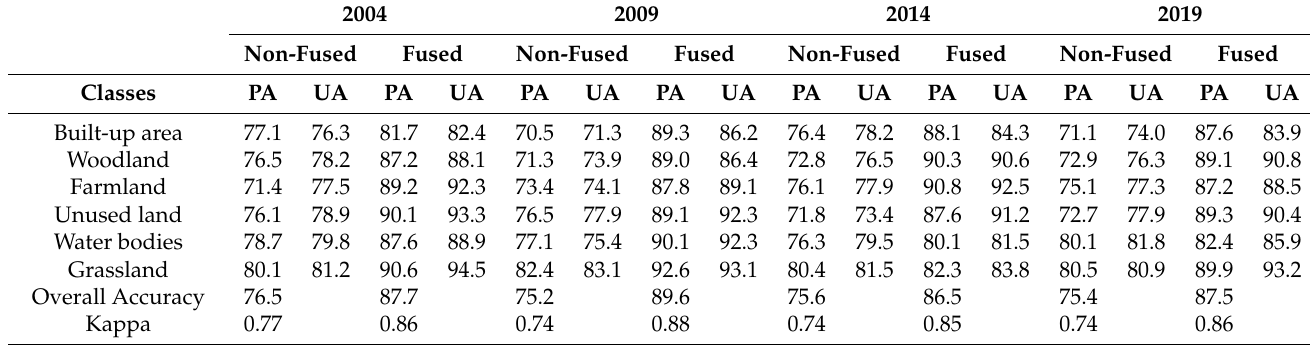
Table 4. Accuracy assessment values for the LULC using non-fused and fused images by 2004, 2009, 2014 and 2019. Producer accuracy = PA; user accuracy = UA.